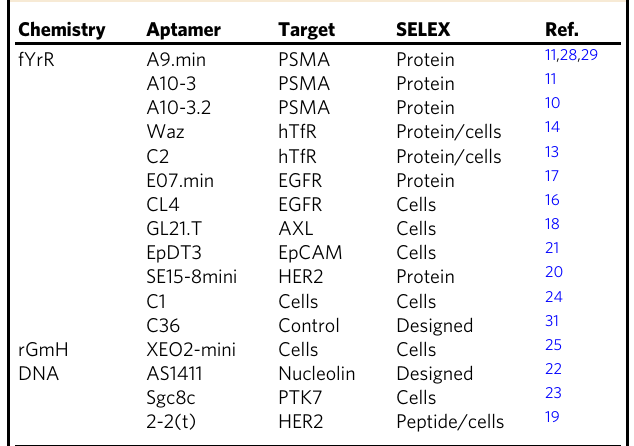
Table 1 Aptamers used in this study.